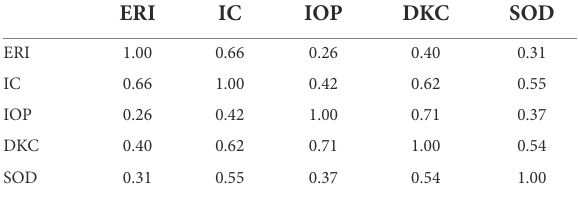
TABLE 1 Correlation matrix of dependent and independent variables.